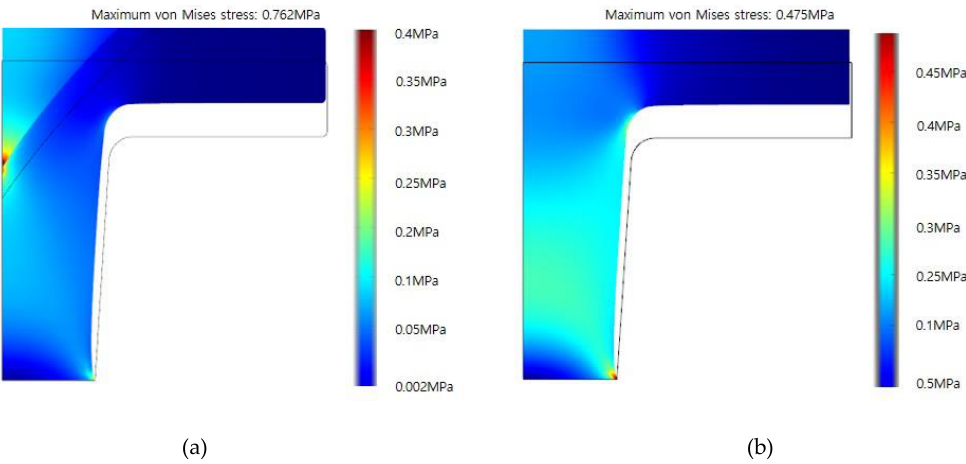
Figure 9. Stress analysis results for ( a ) the partially swelled condition and ( b ) the fully swelled